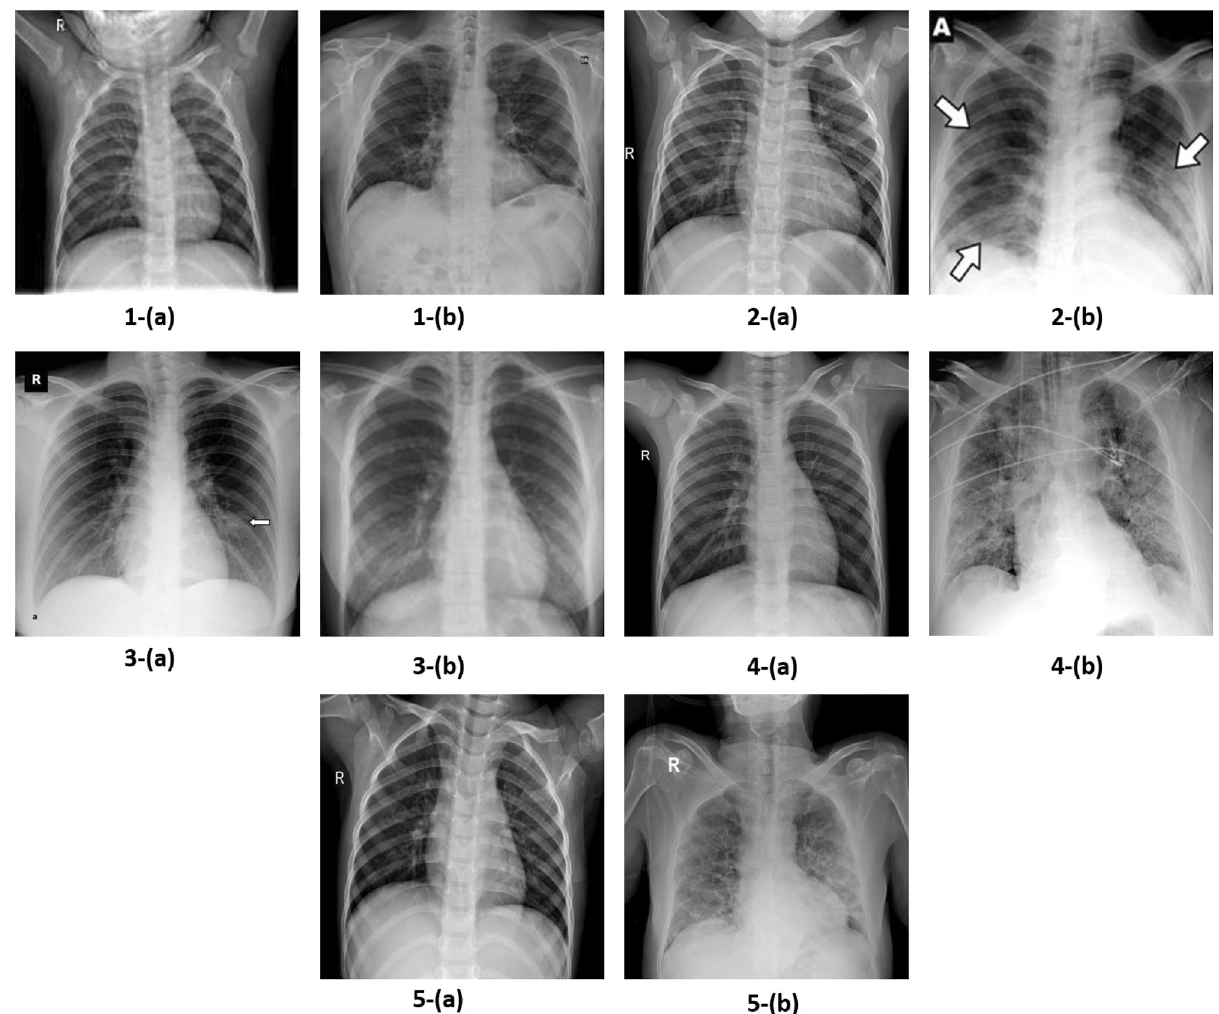
Figure 3. Sample images of COVIDx dataset from various repositories, where ( a ) represent normal image and ( b ) represent COVID-19 image from each repository, such as, 1. ActualMed COVID-19 CXR Dataset Initiative 33 , 2. COVID-19 radiography database 61 , 3. COVID-19 CXR Dataset Initiative 62 , 4. COVID-19 Image Data Collection 63 , and 5. COVID-19 CXR dataset 35 .